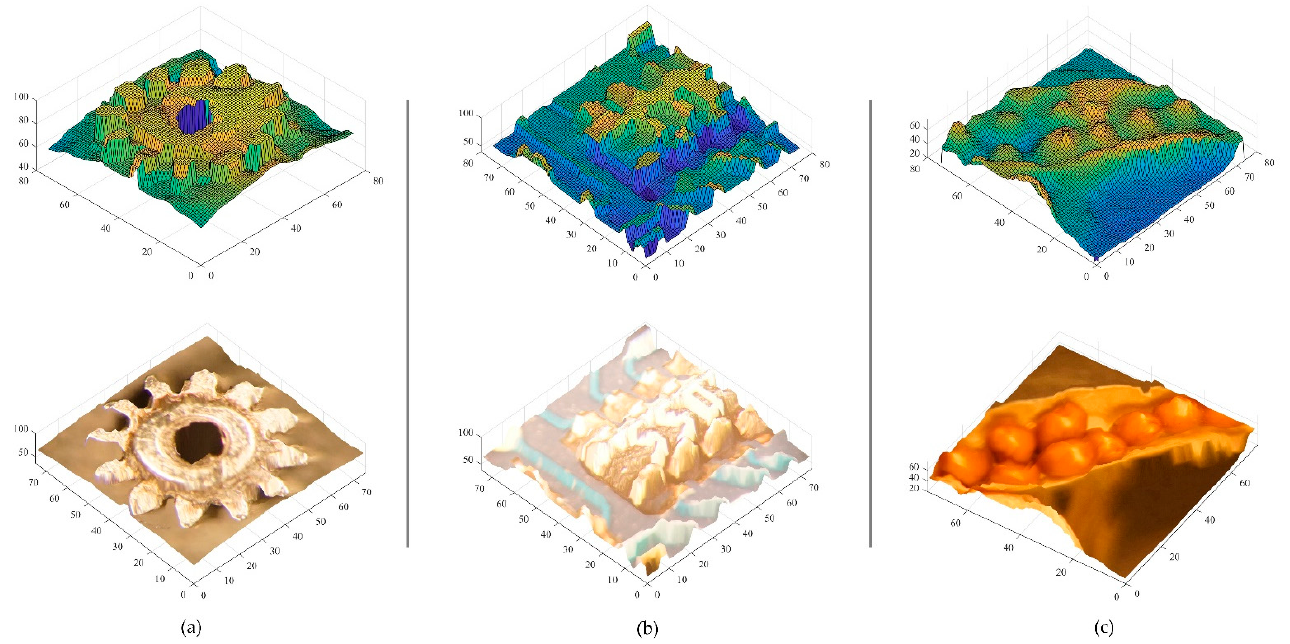
Figure 10. Three-dimensional proposed depth map and reconstructed point cloud models for ( a ) gear, ( b ) microchip, and ( c ) seedpod.